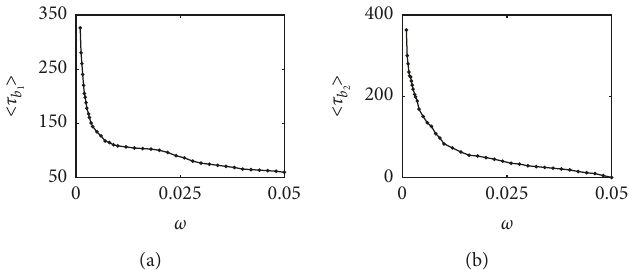
Figure 4: Average bifurcation delay as a function of forcing frequency bifurcation τ b . Other parameter values are fixed same as in Figure (cid:26) 2 (cid:25)